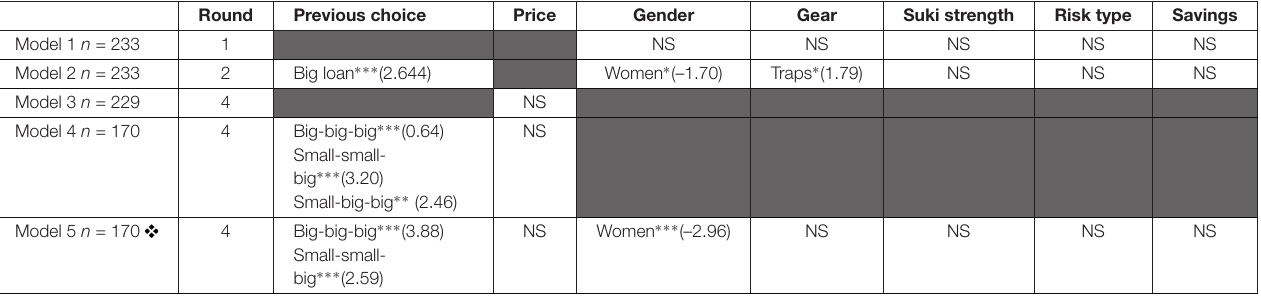
TABLE 4 | Summary of model results showing the variables used in the regressions and which ones came out as predictive of bigger loan choices in round 1, 2, or 4. Round Previous choice Price Gender